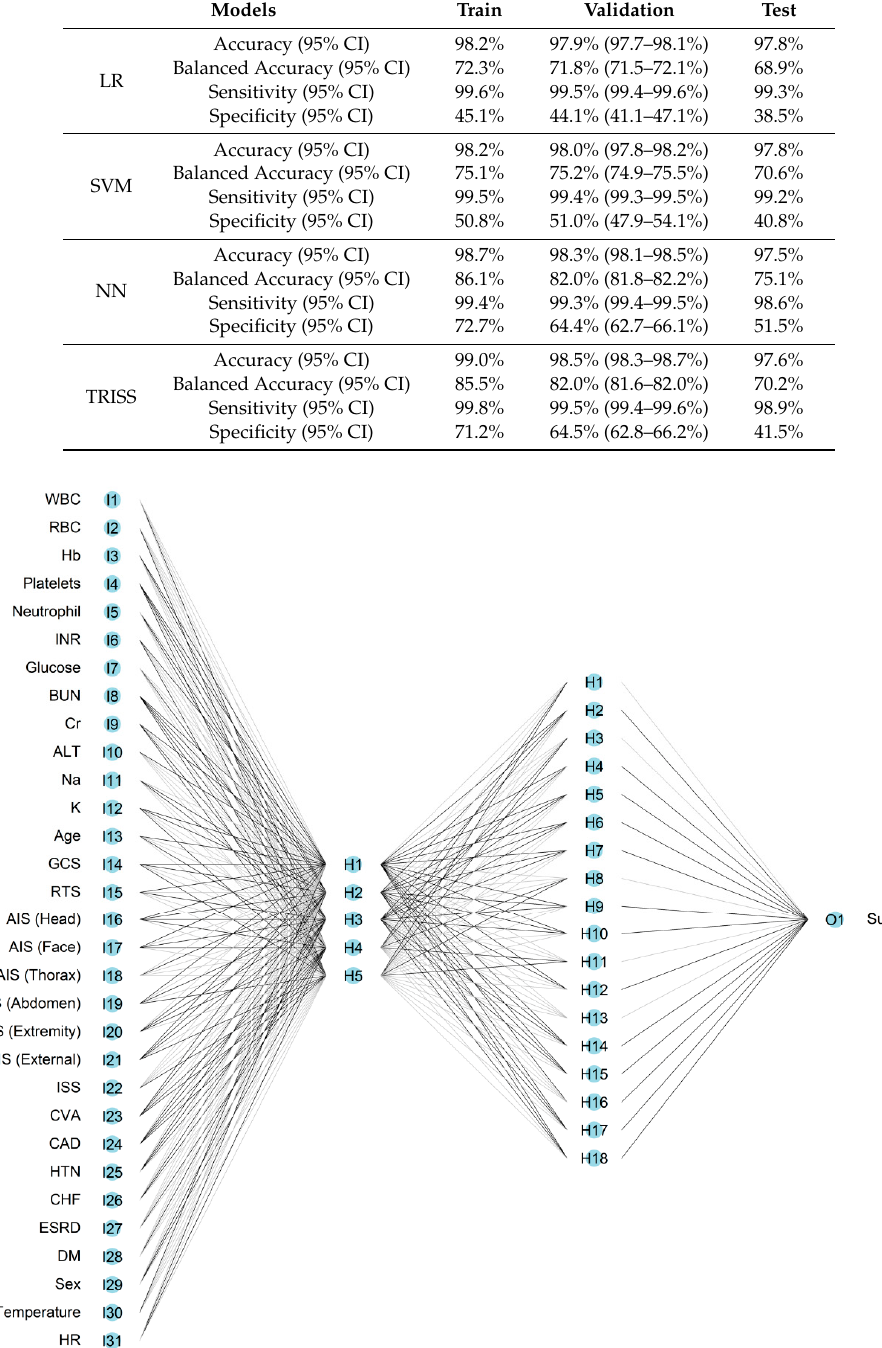
Figure 1. Architecture of the four-layered neural network.